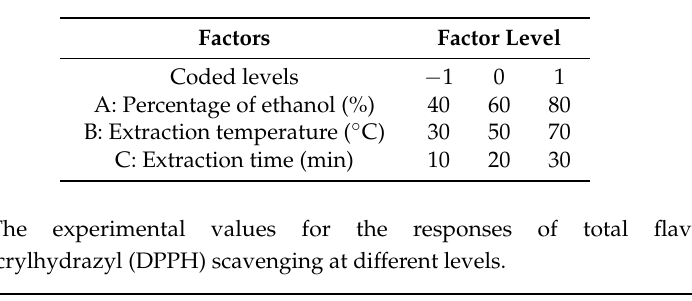
Table 1. Independent factors and their levels used in the response surface design.